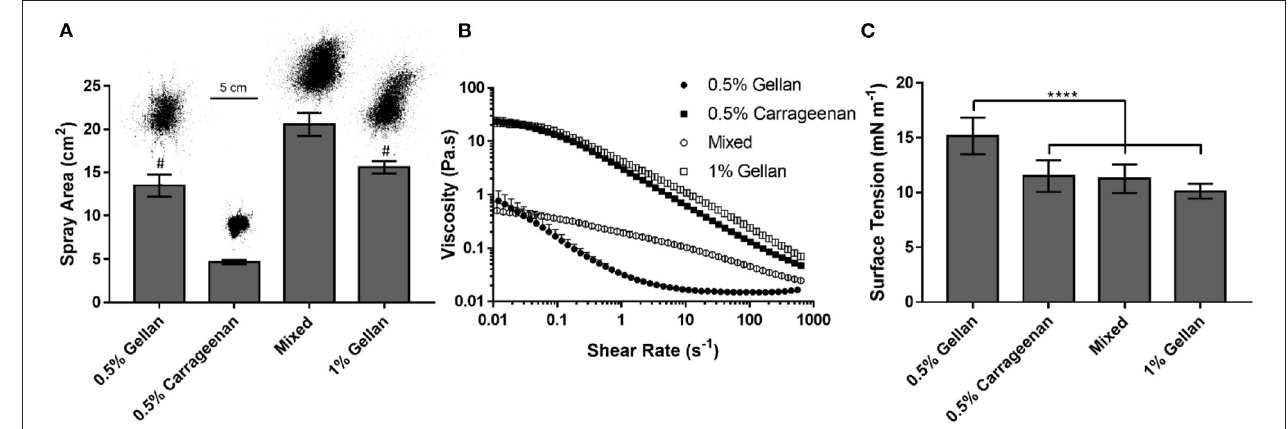
FIGURE 3 | (A) Spray area covered by each formulation, with a representative image of each distribution. The mixed system contains 0.25% gellan and 0.25% carrageenan. (B) Shear rate ramps of each formulation. (C) Surface tension of each formulation. All graphs show mean ± SD ( n = 3). Panels (A,C) show the results of ordinary one-way ANOVAs with a post-hoc Tukey’s multiple comparisons test. In (A) , all columns differ significantly from each other except 0.5% gellan and 1% gellan, indicated by #.